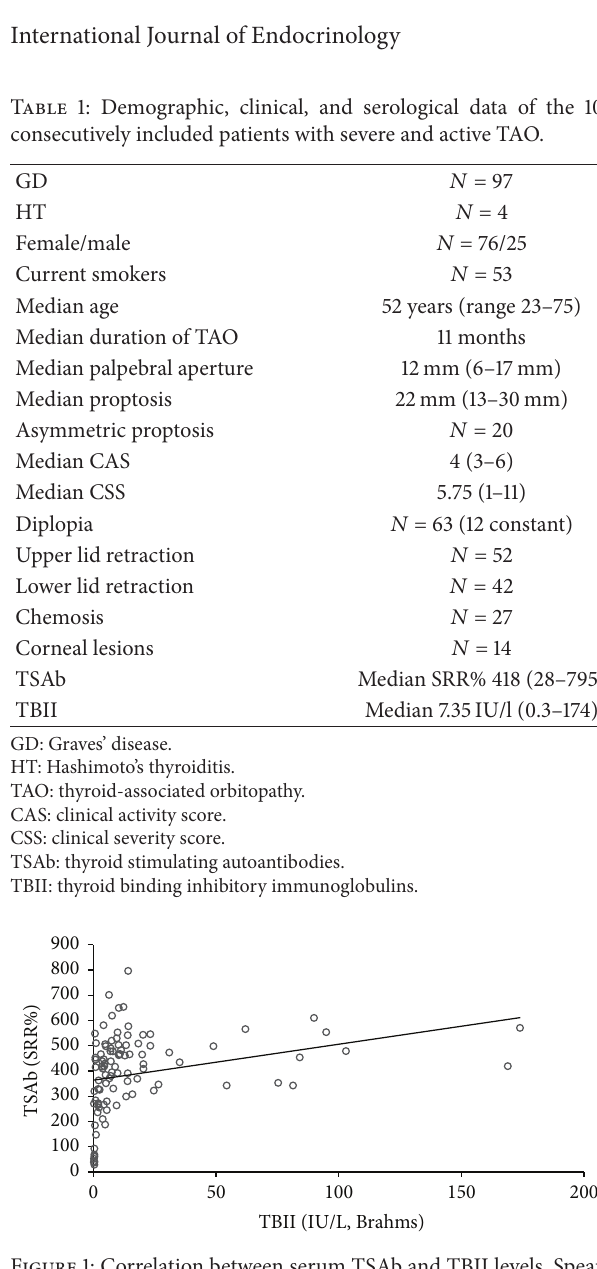
Figure 1: Correlation between serum TSAb and TBII levels. Spear- man’s rho = 0.538; 𝑃 < 0.001 .